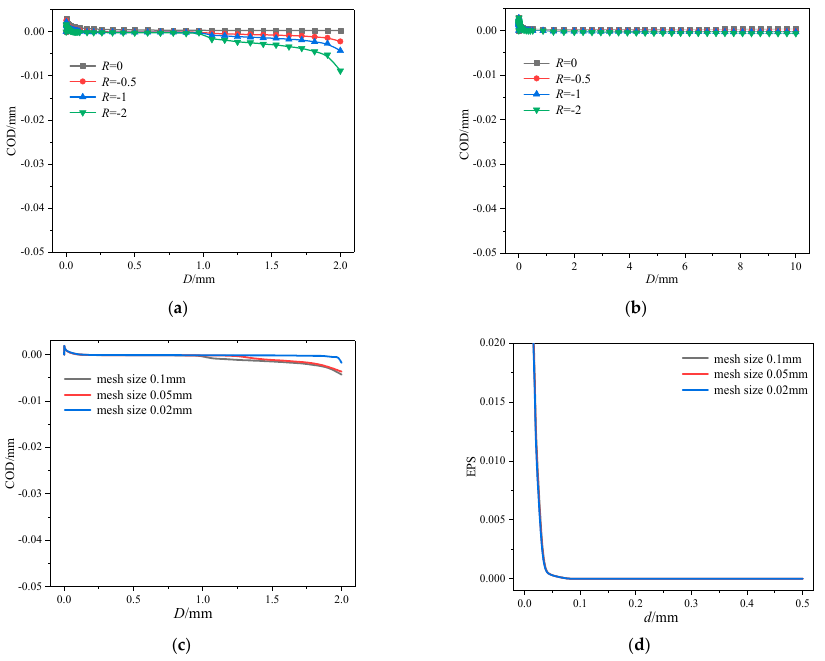
Figure 3. Researches of contact between crack surfaces: ( a ) effect of R on COD for K3-N, ( b ) effect of R on COD for K1-S, ( c ) effect of mesh size on COD ( R = − 1), ( d ) effect of mesh size on EPS( R = − 1).